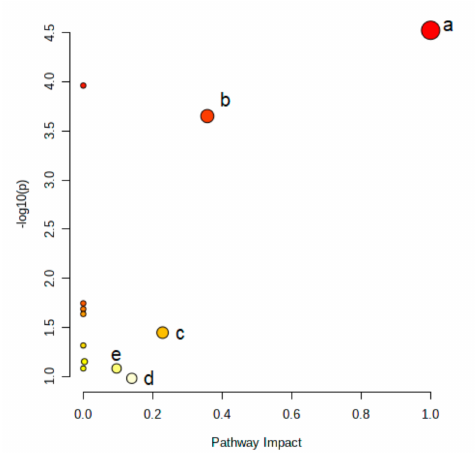
Figure 4. Summary of pathway analysis in patients with highest vs. lower oxidative